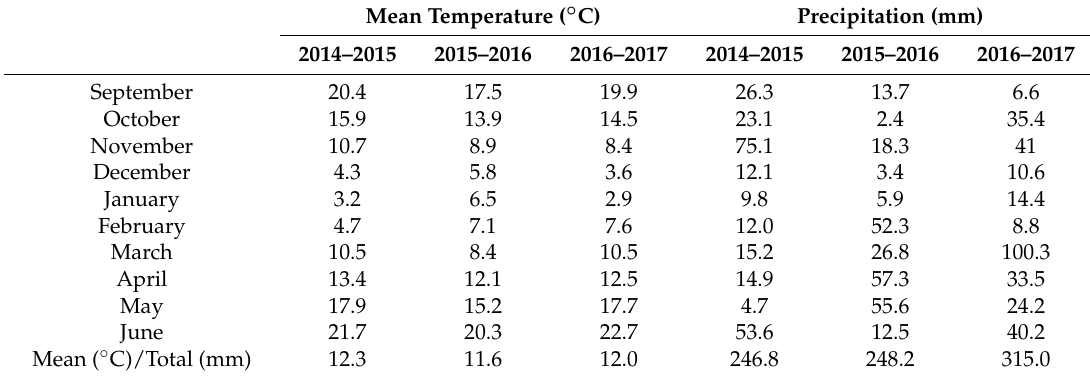
Table 4. Monthly temperature and precipitation along the three growing seasons.